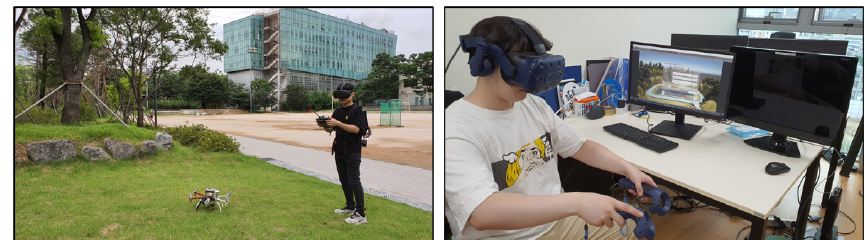
Figure 4. Drone player ( left ) and remote expert ( right ).